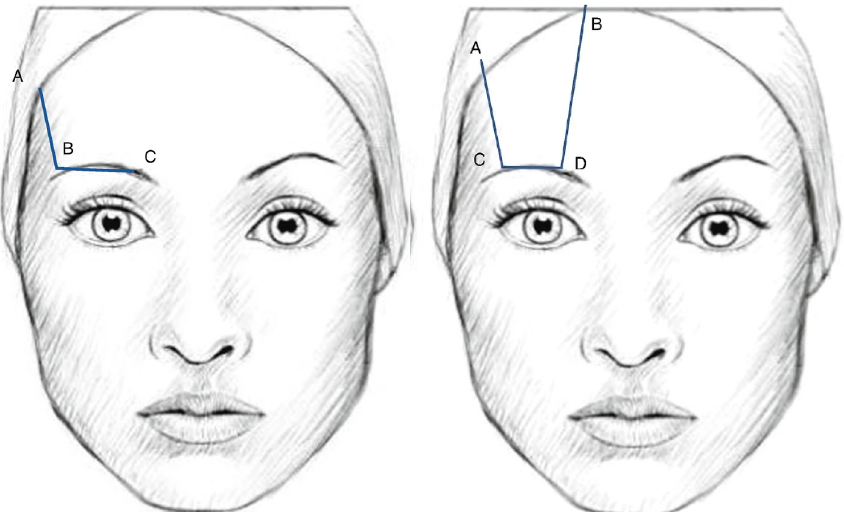
Figure 19. The use two-needle thread in L Shape ( left ) and U shape ( right ). For the L shape, (A) denote the entry point, (B) the anchoring point and (C) the exit point. For the U shape, (A,B) denote the entry and exit point respectively. (C,D) denote the anchoring points. Reprinted with permission from Ref.